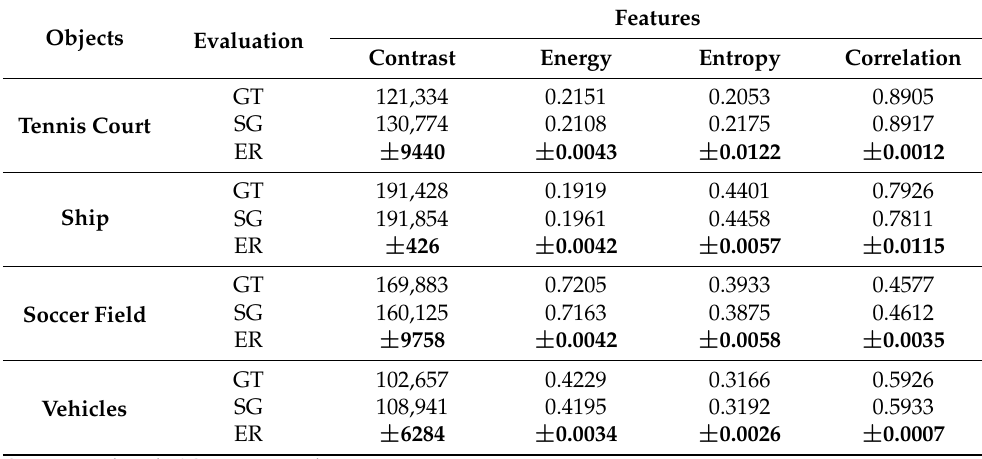
Table 1. Attribute values of different Haralick features for labeled objects compared with GT with errors on AID. Features Objects Evaluation Contrast Energy Entropy